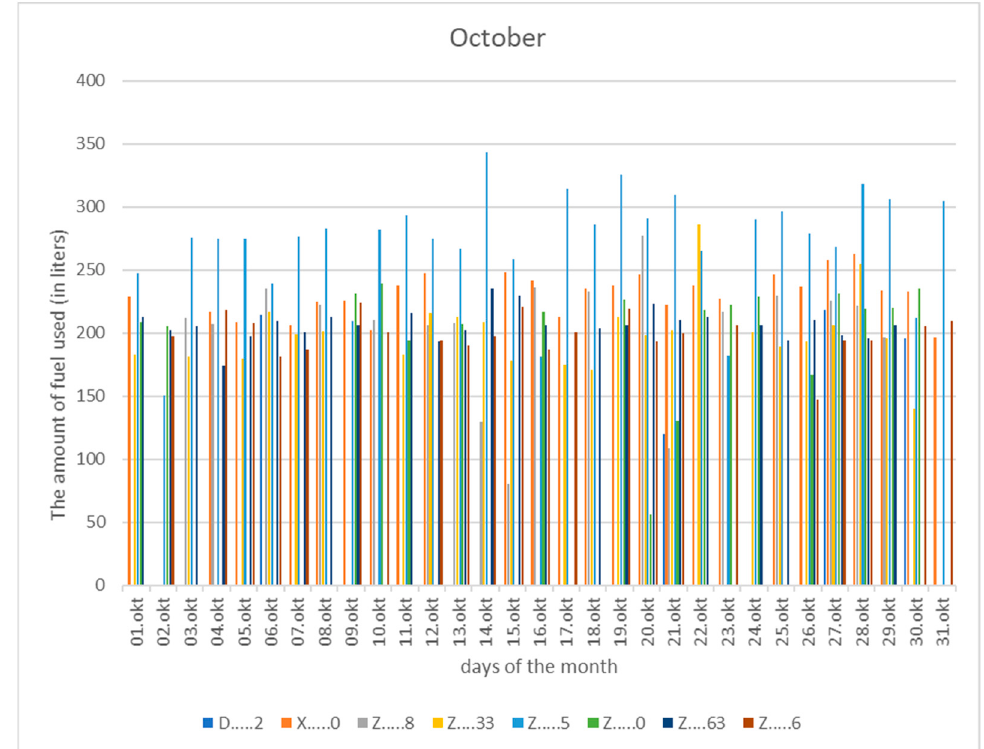
Figure 3. The amount of fuel used (in litres) for each vehicle in October.